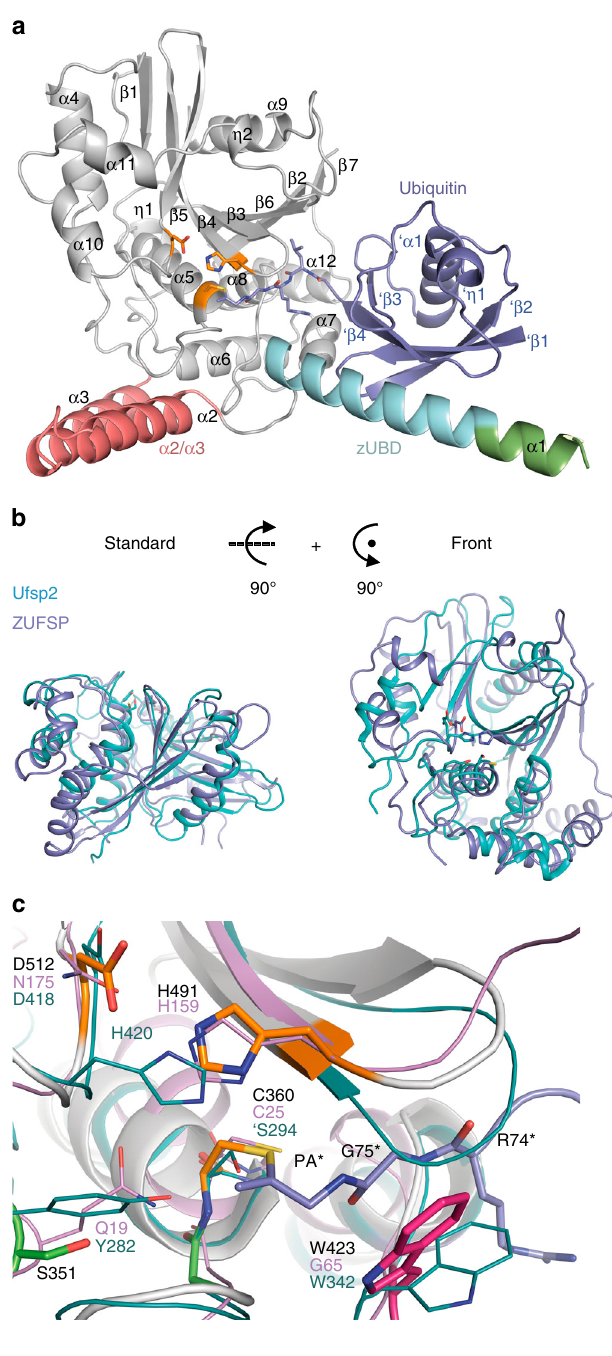
Fig. 3 Crystal structure of ZUFSP 232-578 in covalent complex with Ub-PA. a Overview of the crystal structure in cartoon representation. The catalytic core of ZUFSP is shown in gray, ubiquitin in blue. The MIU region on helix α 1 of ZUFSP is colored green, the zUBD region in cyan. The putative S1 ’ ubiquitin-binding α 2/ α 3 helices are shown in red. The catalytic triad is shown as sticks and colored orange. b Structural superposition of the catalytic domain of ZUFSP (blue) and UFSP2 (3OQC, cyan) in two perspectives. RMS distance is 3.65 Å over 200 residues. c Magni fi cation of the active site of ZUFSP (gray). The catalytic triad is colored orange, putative components of the oxyanion hole in green and Trp-423, closing the substrate binding groove directly next to the active site, is in dark pink. Ubiquitin is shown in blue color. The active sites of Ufsp2 (cyan) and papain (violet) are superimposed. Structurally equivalent residues of Ufsp2 and ZUFSP are shown as sticks. Important residues of ZUFSP (black), Ufsp2 (cyan) and papain (violet) are labeled. Important ubiquitin residue labels contain asterisks. In the available structure (3OQC) of UFSP2, the catalytic cysteine was mutated to a serine, indicated here as ‘